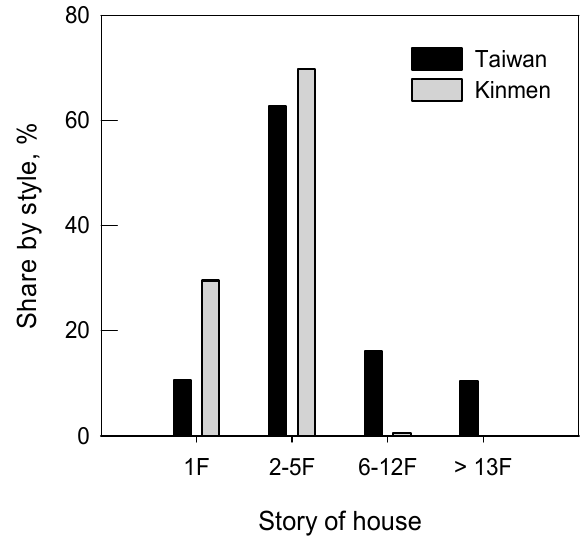
Figure 4. Style of building with a SWH installed (2001–2018) in Taiwan and Kinmen County.